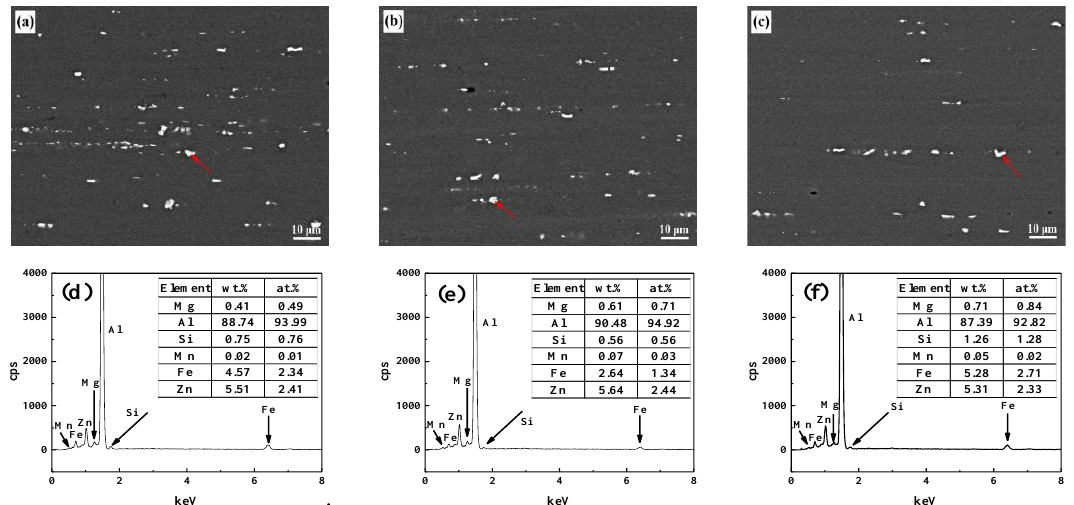
Figure 3. SEM images (ED – TD plane) and EDS results of alloys with different Zn/Mg ratios; ( a , d ) 11.4; ( b , e ) 8.1; ( c , f ) 6.1.